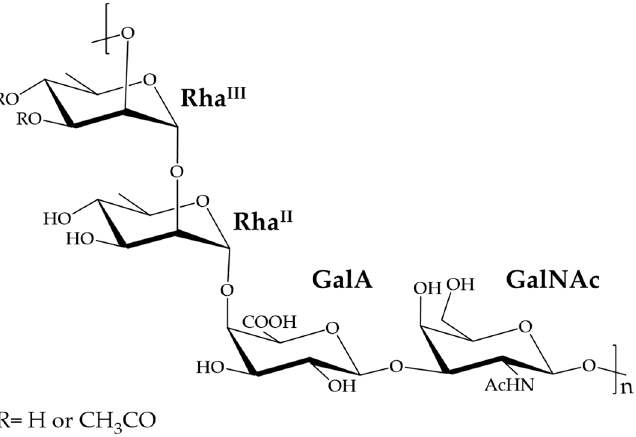
Figure 1. S. flexneri serotype 6 OAg repeating unit (RU)